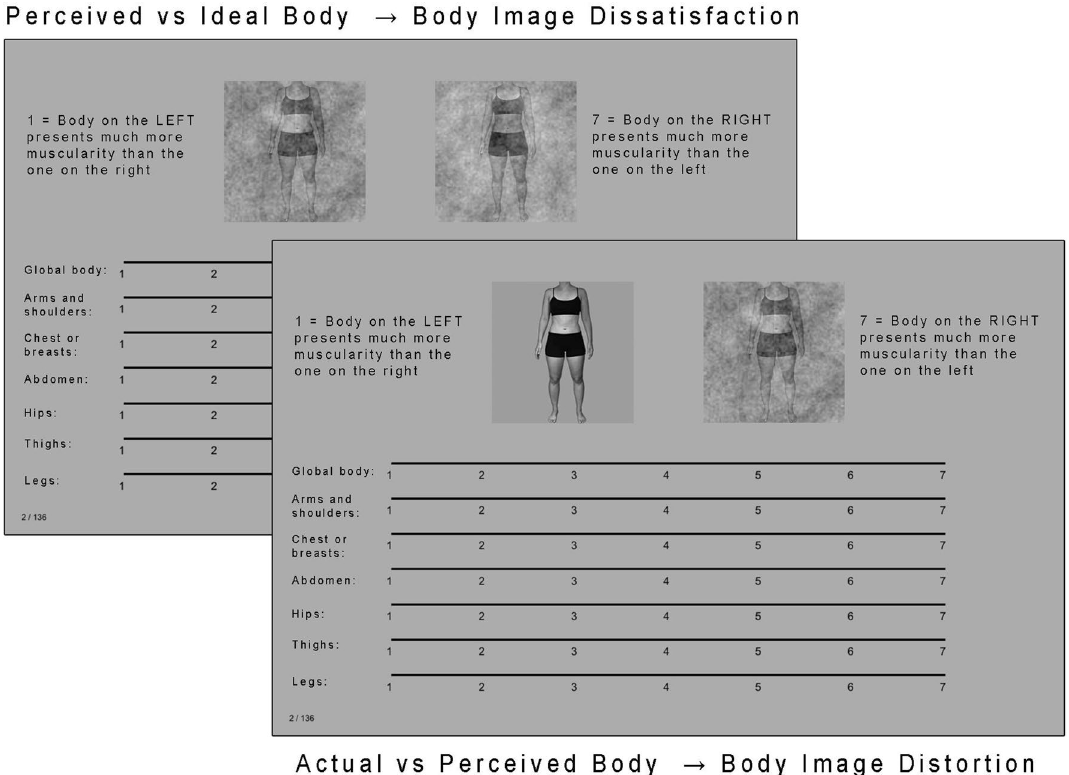
Figure 3. Examples of trials during the image-comparison phase. The left one represents the assessment of implicit muscularity dissatisfaction, and the right one represents the assessment of implicit muscularity